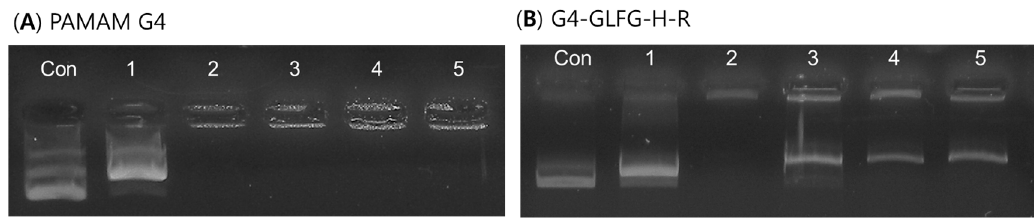
Figure 7. Plasmid DNA release test by cathepsin B, pDNA(control), pDNA + Cathepsin B (lane 1), Polymer:pDNA polyplex (G4-GLFG-H-R, 10:1, PAMAM G4, 4:1, w / w ) (lane 2), polyplex + cathepsin